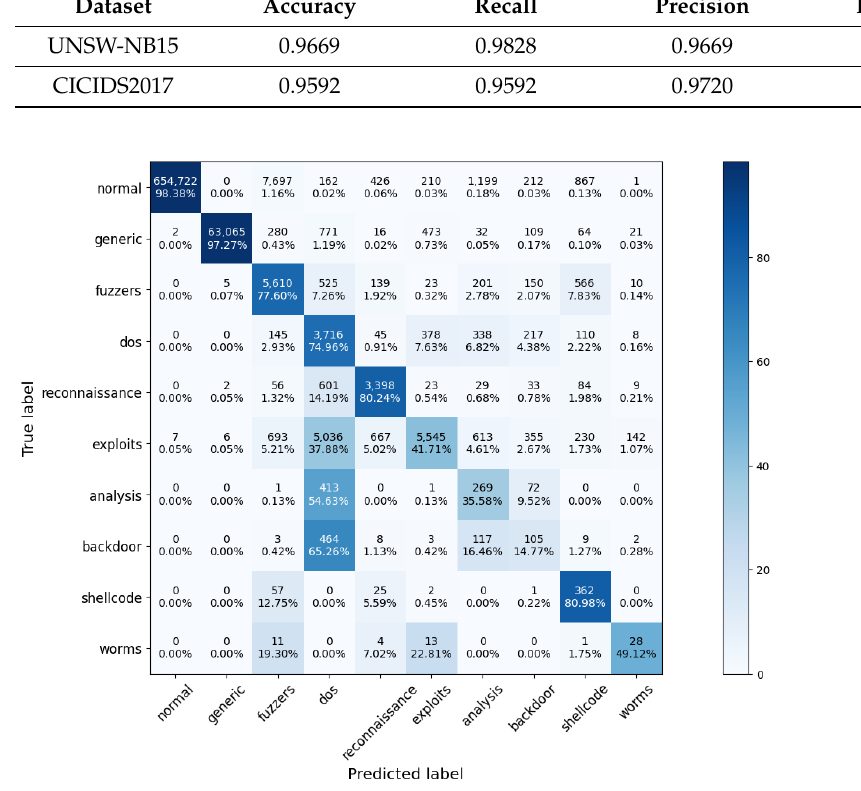
Figure 4. Identifying attack type confusion matrix, which shows how the predicted attacks compare against the actual ones.